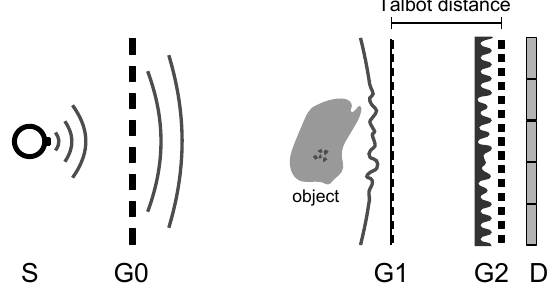
Figure 1. Sketch of a Talbot-Lau interferometer with an X-ray source S, the source grating G0 , an object, the phase grating G1 , the analyser grating G2 and a flat-panel X-ray detector D. The pattern in front of G2 illustrates the Talbot intensity pattern, which is produced by G1 and distorted by the